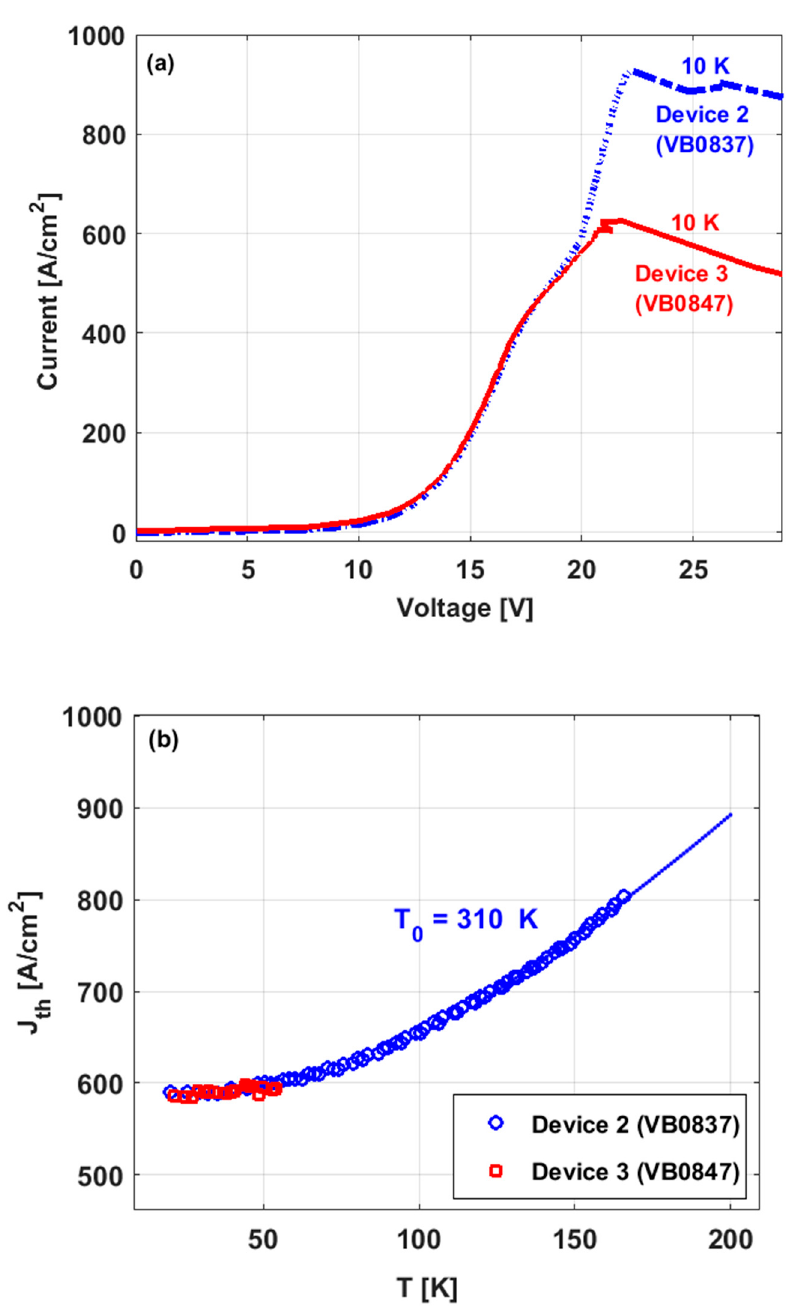
Figure 6. ( a ) Current–voltage curves of Device 3 (VB0847) vs. Device 2 (VB0837) at low temperature. ( b ) Threshold current versus temperature of Devices 3 and 2.